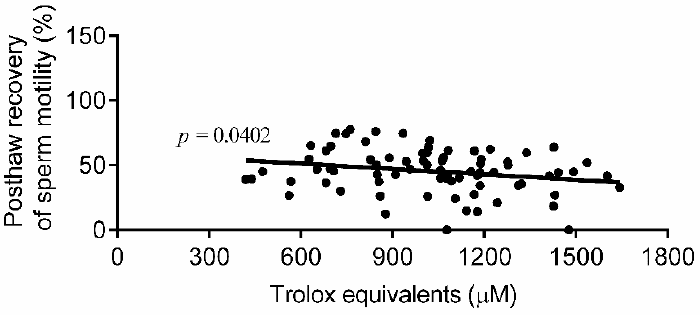
Figure 2. Correlation between post-thaw recovery of sperm motility and Trolox equivalents, as measured by the CUPRAC method ( n = 77).